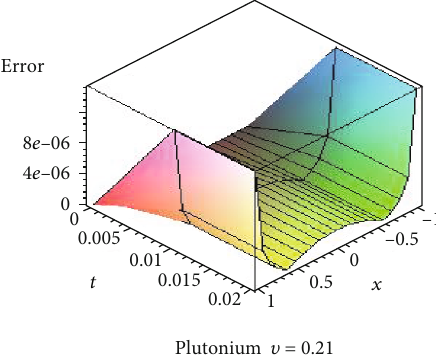
Figure 12: The value absolute error by TMM at N = 20 and T = 0 : 02 .